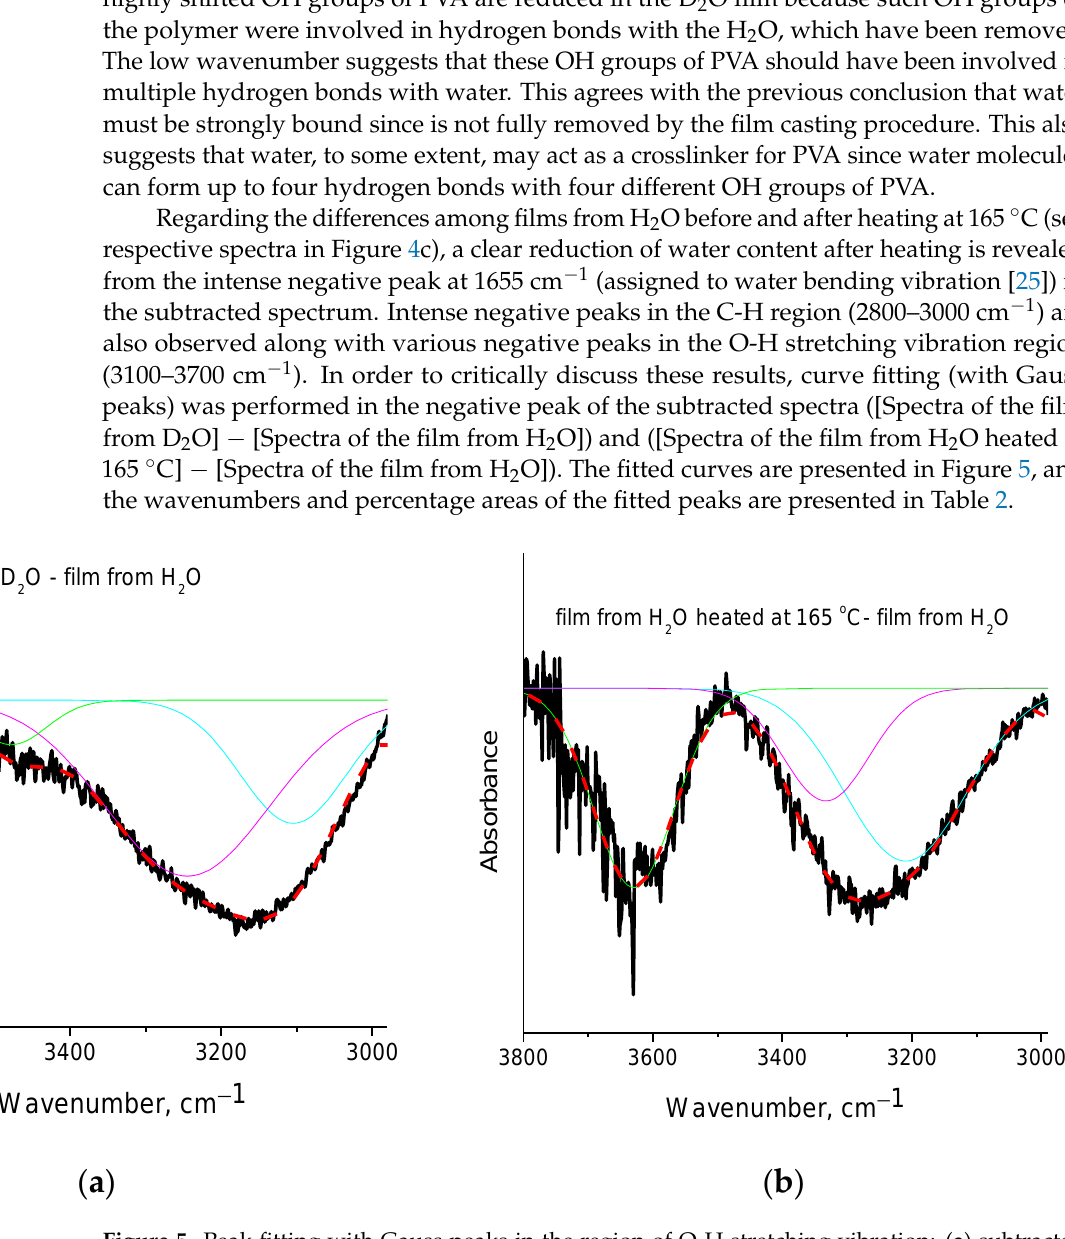
Figure 5. Peak fitting with Gauss peaks in the region of O-H stretching vibration: ( a ) subtracted spectrum ([Spectra of the film from D 2 O] − [Spectra of the film from H 2 O]); ( b ) subtracted spectrum ([Spectra of the film from H 2 O heated at 165 °C] − [Spectra of the film from H 2 O]). The color lines are the Gauss fitted peaks.